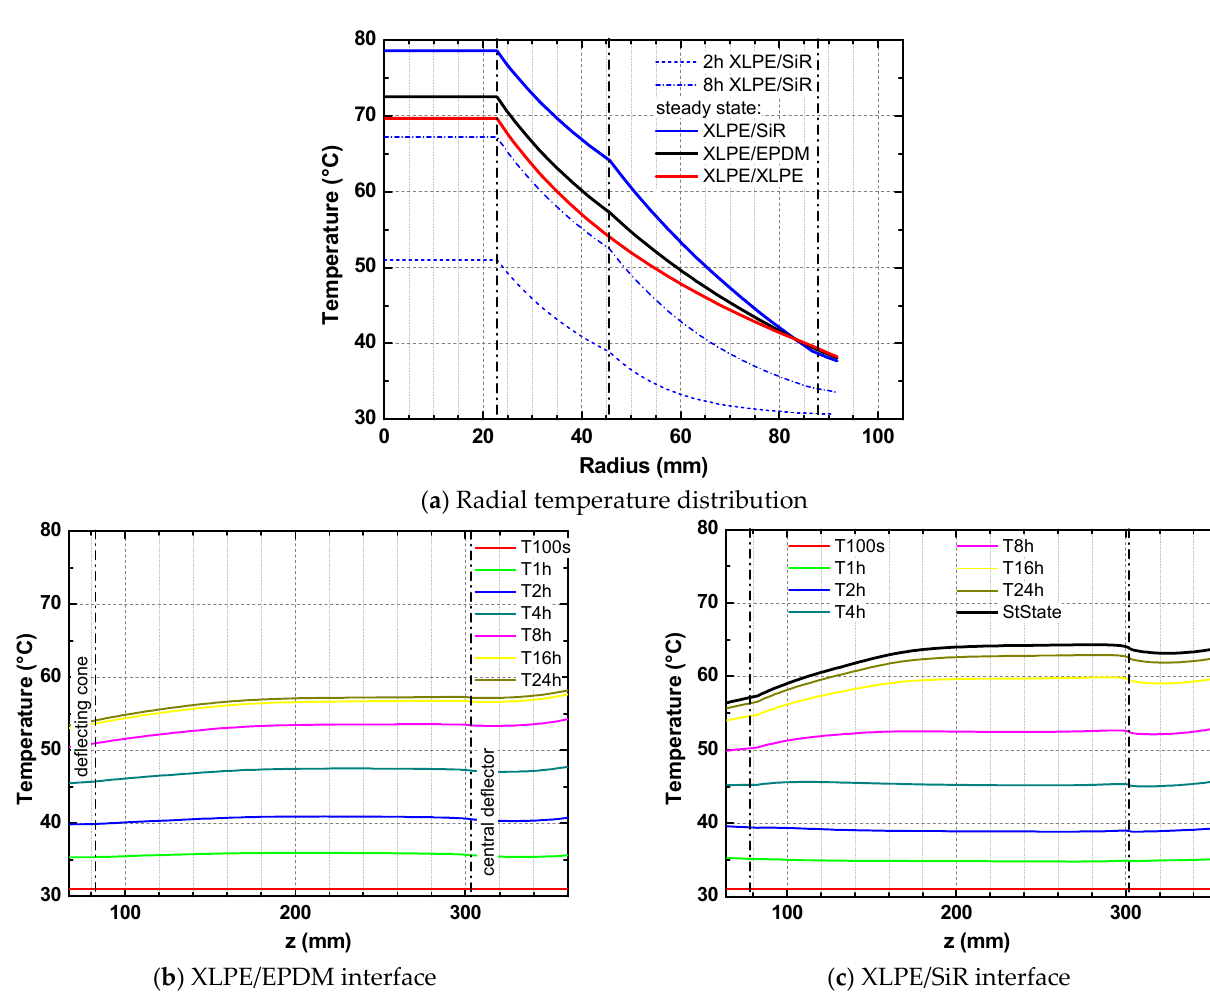
Figure 10. ( a ) Temperature profiles along the radial direction in quasi-steady state (24 h) for the considered three couples of materials and profiles during thermal transient for XLPE/SiR at 2 h and 8 h. ( b , c ): Temperature distributions along the interface, for XLPE/EPDM and XLPE/SiR joints at different times. In all cases, 1 kA is injected to the conductor and the initial temperature is 30 °C.